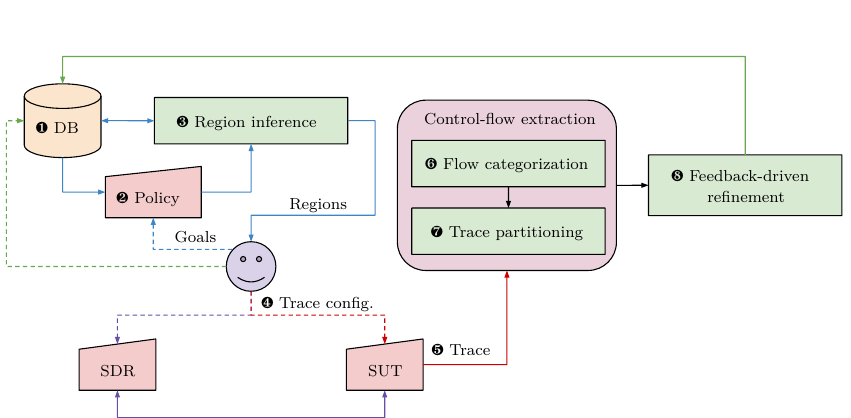
Figure 11: Overview of Incision applied to analyze the Huawei R216h baseband firmware. We indicate the human-in-the-loop by a purple face. We depict data-flow by block arrows where propagation is automated by Incision , and dashed arrows where manual intervention is